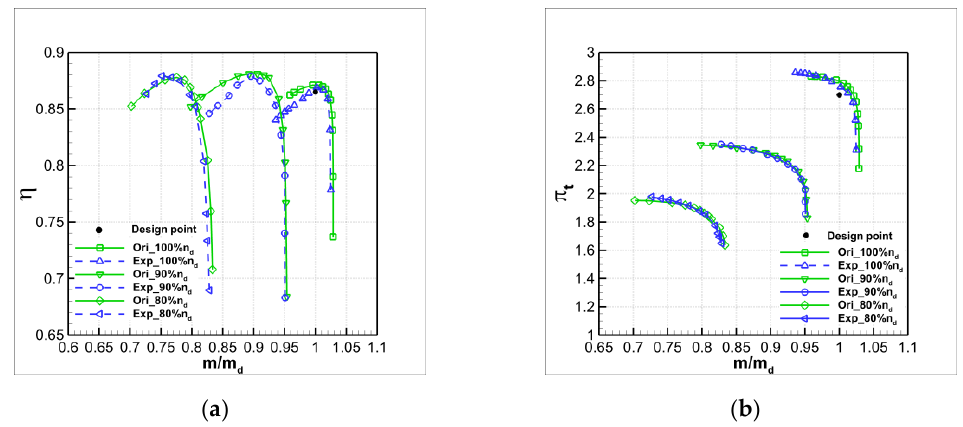
Figure 5. Calculated and measured compressor performance maps. ( a ) Adiabatic efficiency at the different normalized mass flow; ( b ) total pressure ratio at the different normalized mass flow.